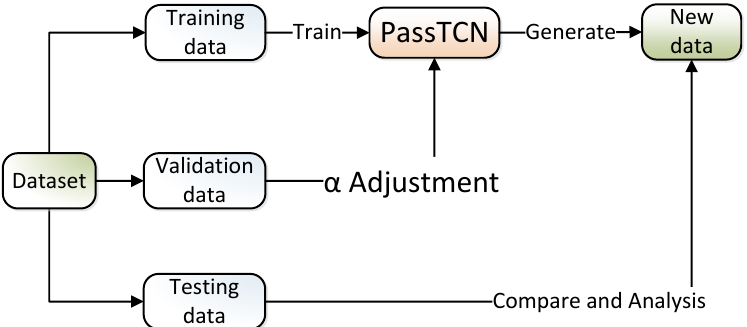
Figure 4. Verification process of hyperparameter α